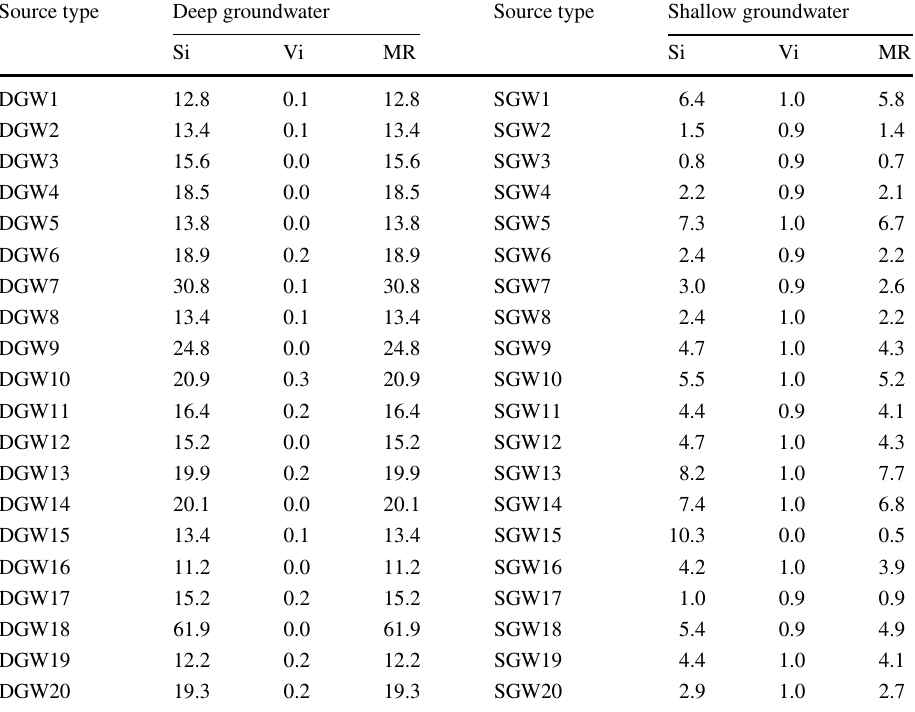
indices for evaluating rock weathering